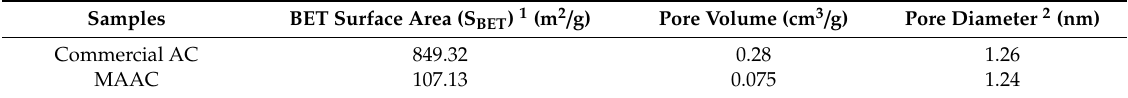
Table 1. Textural parameters of Commercial AC and MAAC beads.